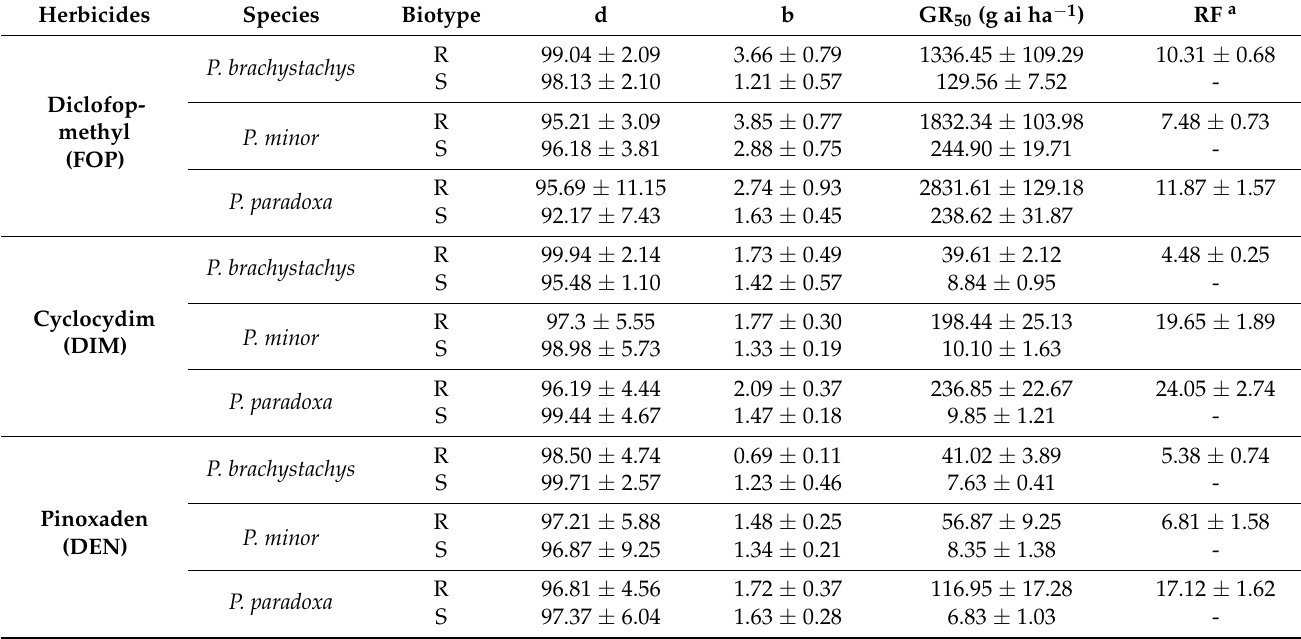
Table 1. Estimated parameters of the log-logistic equation used to calculate the herbicide doses required for 50% reduction of the dry weights (GR 50 ) of R and S biotypes of Phalaris species.